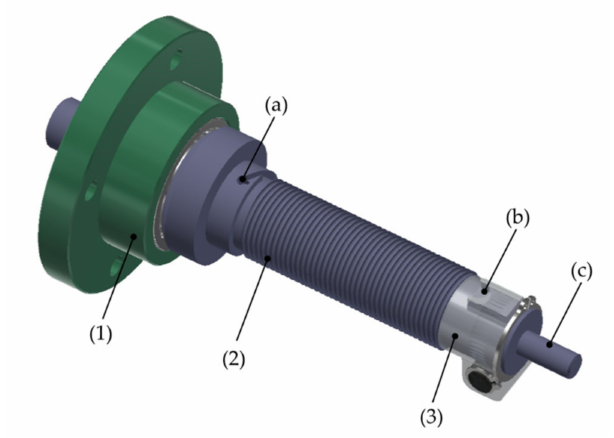
Figure 5. CAD model of the motor shaft system: (1) bracket; (2) shaft; (3) tensioner; (a,b) cable connection points; (c) end of the shaft for encoder clamping.